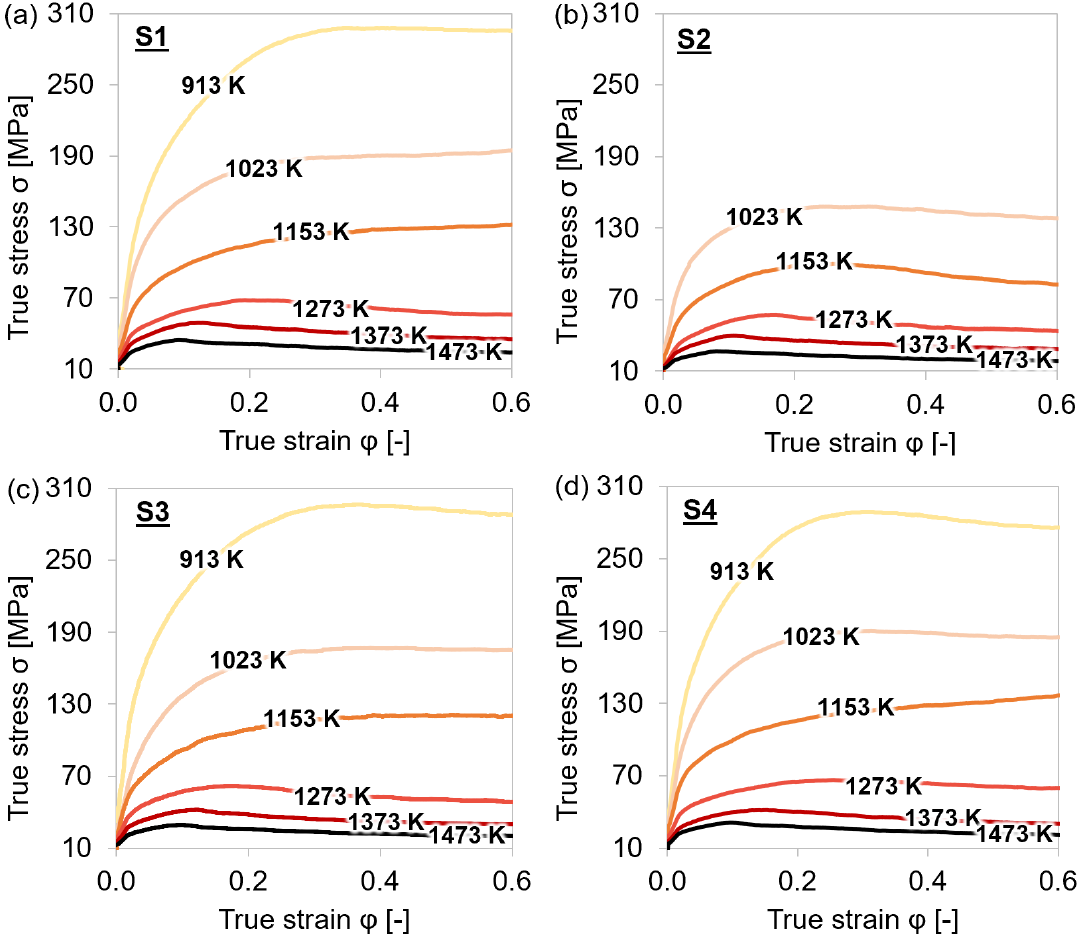
Figure 5. Stress–strain curves during single-hit compression tests with 25 s holding time before deformation and 0.01 s − 1 strain rate at 913–1153 K. ( a – d ) MA steel grades S1–S4.